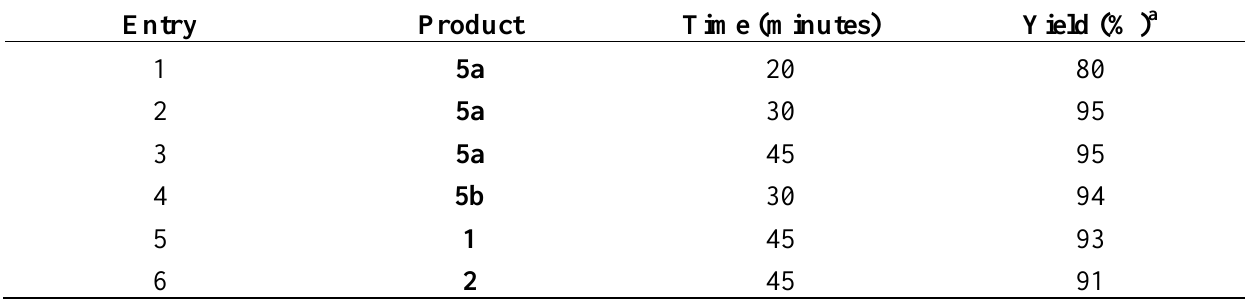
Table 3 : Ultrasound assisted cross coupling reactions between tosylates and Grignard